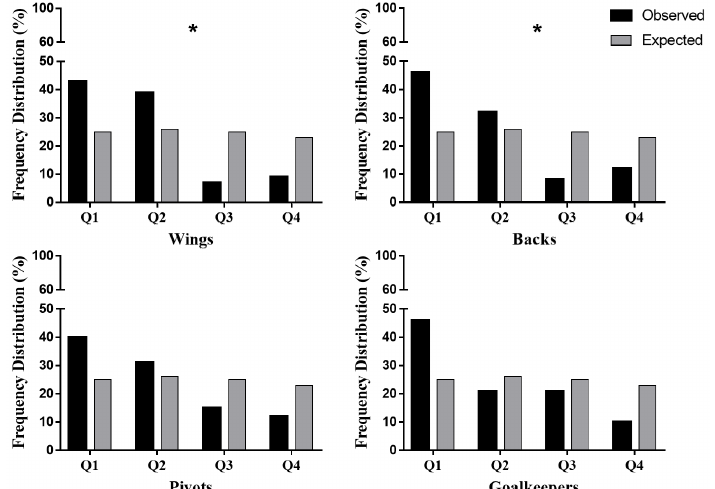
Figure 1 - Distribution of quarters of birth according to the playing position of the Brazilian team’s handball male athletes. *= statistical difference between the observed and expected distribution (p < 0.05).